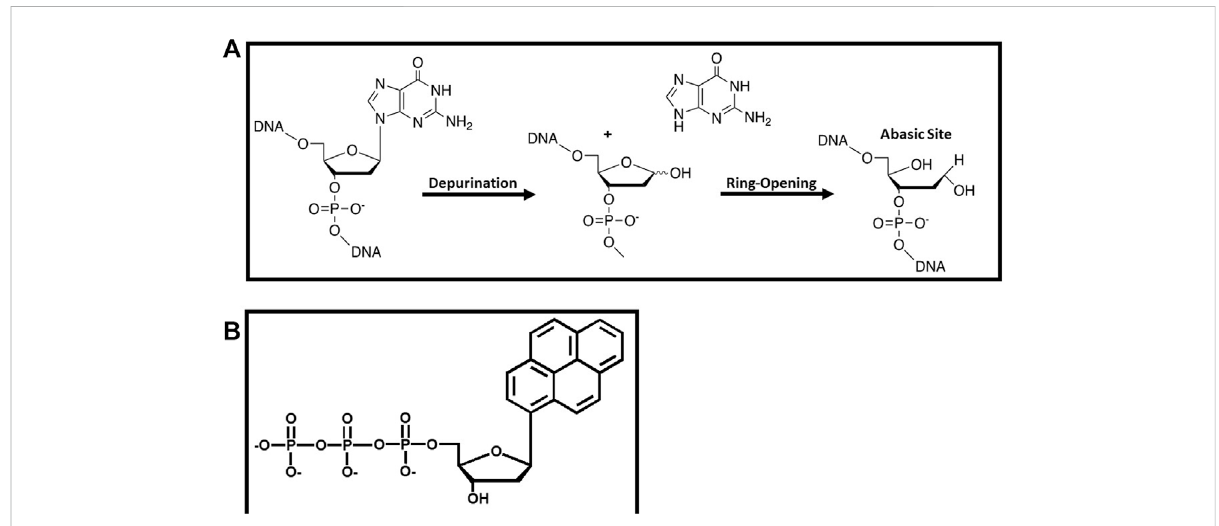
FIGURE 6 (A) Formationandstructureofanabasicsitethatfunctionsasanon-instructionalDNAlesion (B) Structureofpyrenetriphosphateusedtoprobe the replication of an abasic